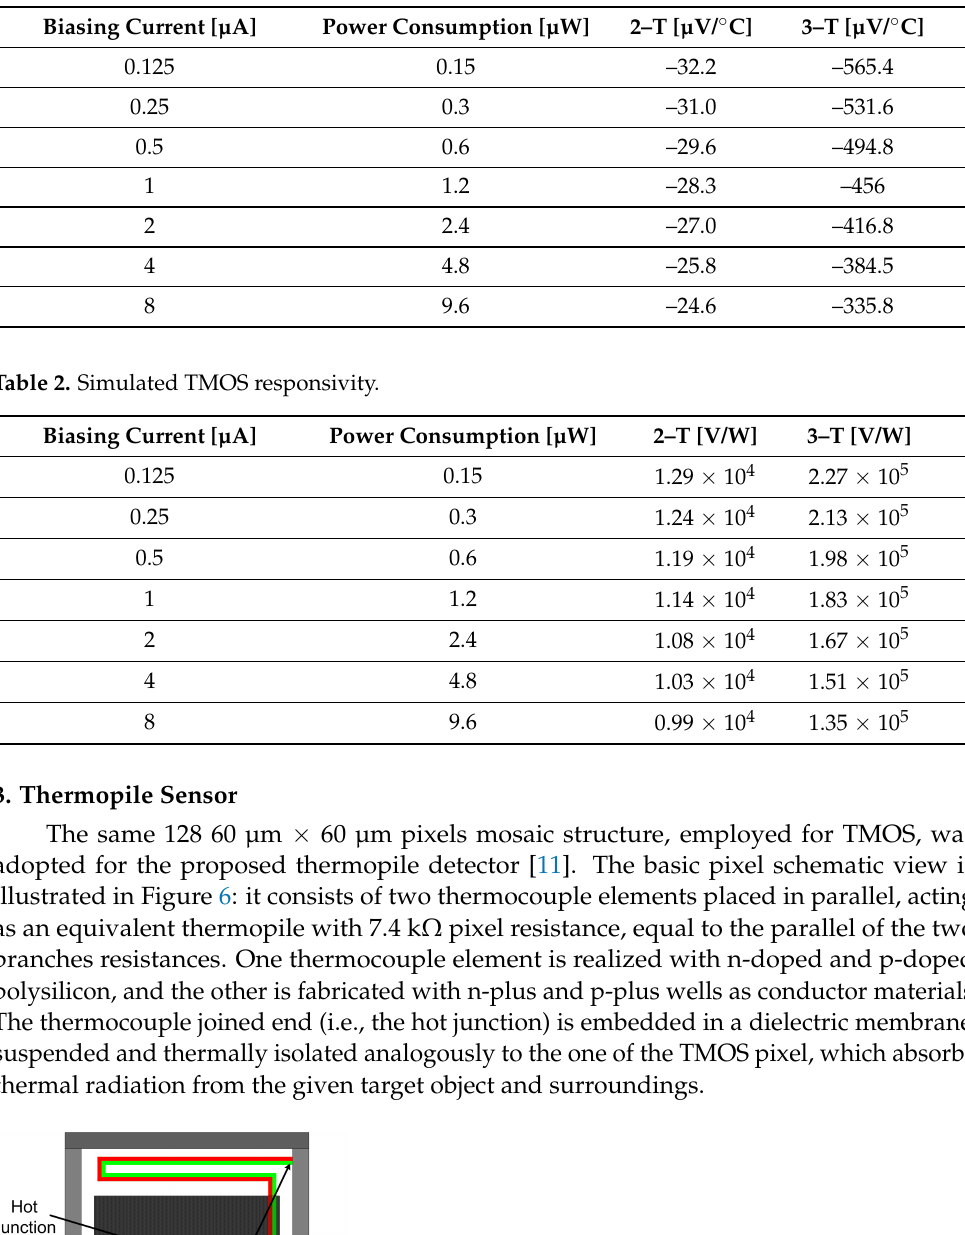
Table 1. Simulated TMOS sensitivity supposing a 1.2 V supply voltage, an ambient temperature equal to 25 ◦ C and a 10 cm × 10 cm black body at 10 cm distance.